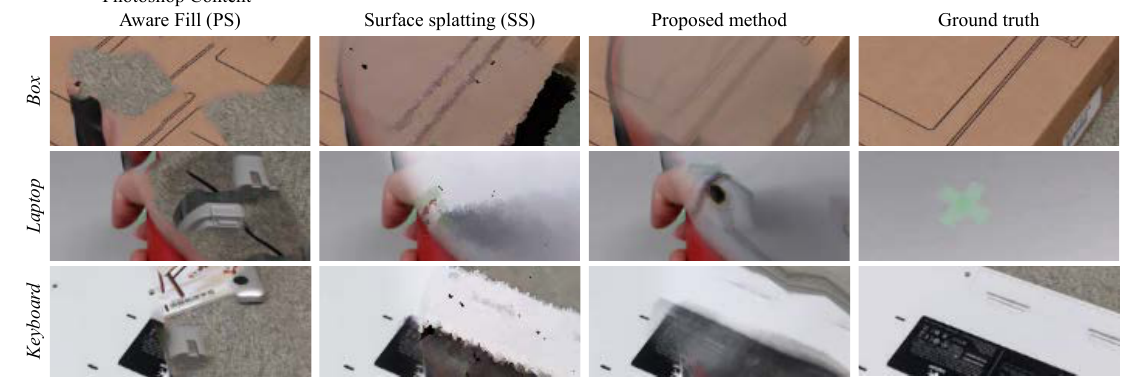
Figure 6. Partially enlarged results corresponding to the green rectangular regions in Figure 5.